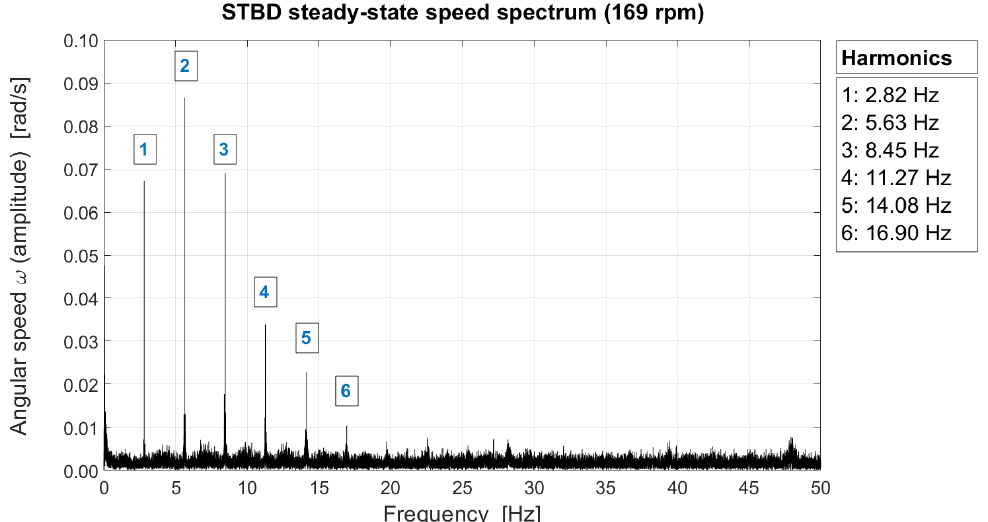
Figure 15. Spectrum of ω ( f ) at n = 169 rpm, in steady-state conditions, at the Starboard-side